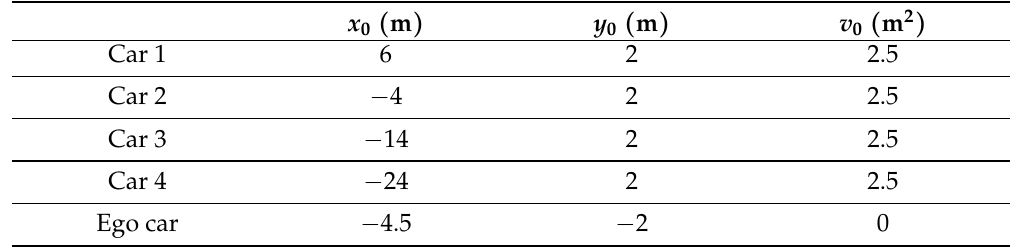
Figure 4. Initial condition for the case studies. Table 2. Initial conditions for